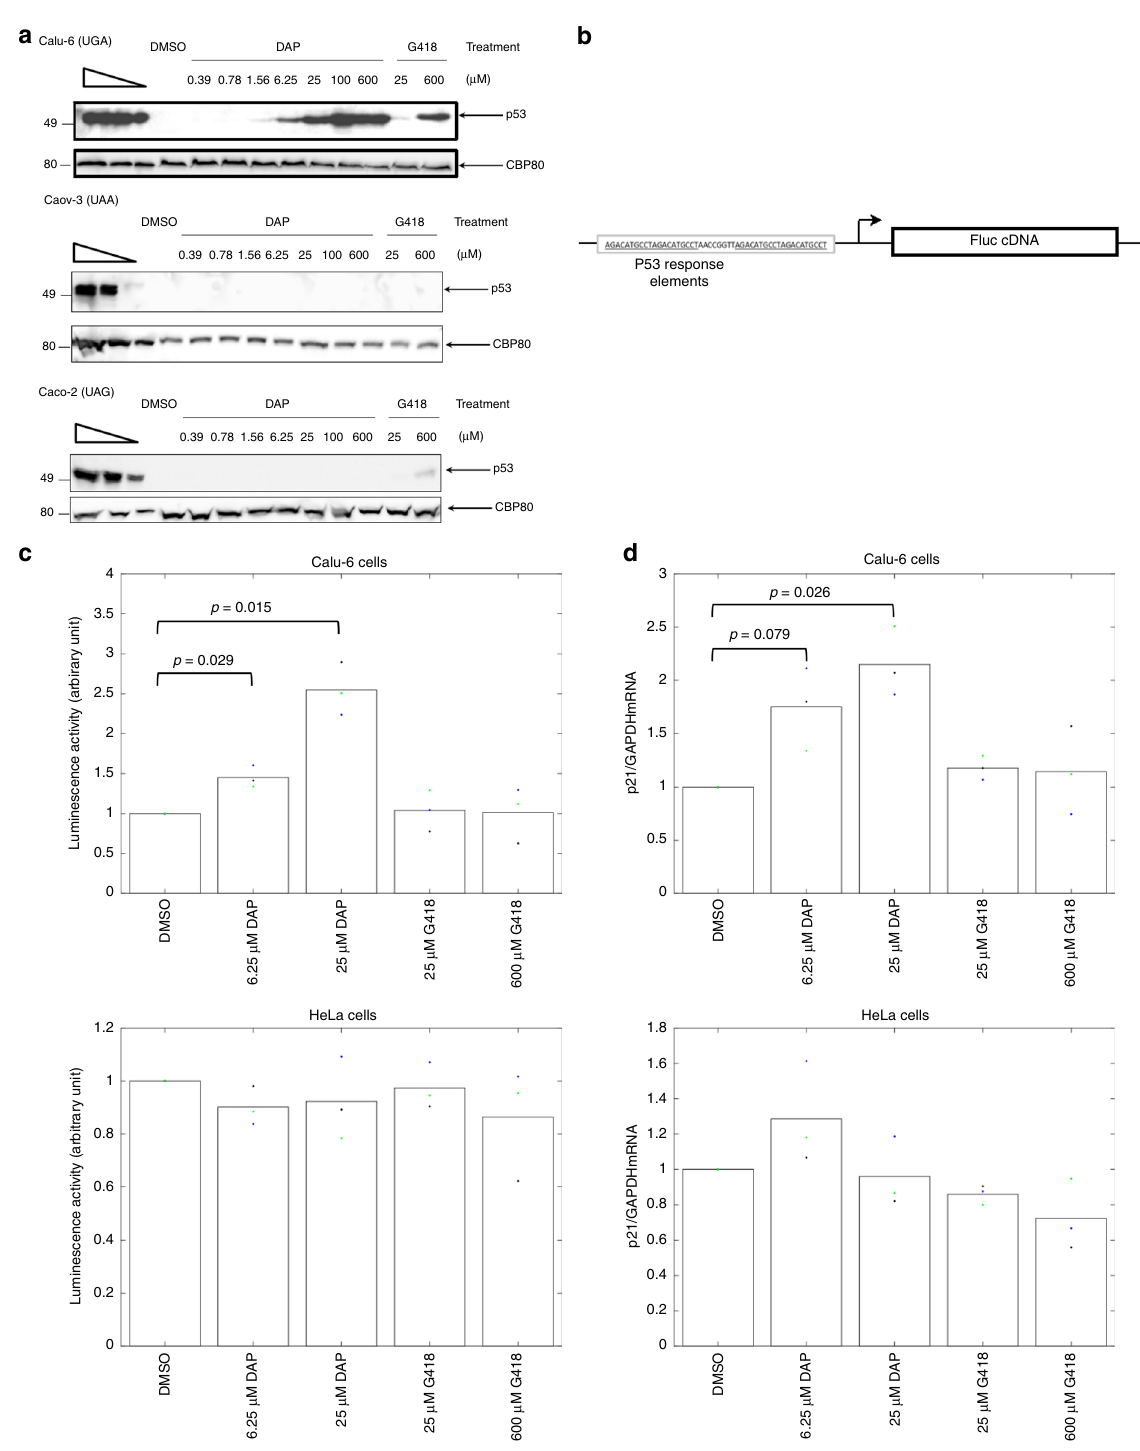
Fig. 2 DAP restores the synthesis and function of p53 in Calu-6 cells. a DAP restores expression of the endogenous TP53 gene if it carries a UGA nonsense mutation but not if it carries a UAA or UAG nonsense mutation. Calu-6 (top), Caov-3 (middle), and Caco-2 (bottom) cells were incubated with increasing amounts of DAP or G418 before protein puri fi cation and monitoring of the p53 protein level by western blotting. The three leftmost lanes show twofold serial dilutions of untreated HeLa cell extract. The molecular weight is indicated to the left of each gel. b Schematic representation of the construct used to measure the function of p53. The construct carries a cDNA encoding the fi re fl y luciferase under a promoter having two p53-responsive elements (underlined). The arrow indicates the transcription start. c Luciferase activity in Calu-6 (upper panel) and HeLa cells (lower panel) transfected with the construct described in b and treated with DMSO, DAP, or G418. The luciferase activity depends on the amount of functional p53 protein. d Level of p21 mRNA measured by quantitative RT-PCR in Calu-6 (upper panel) and HeLa cells (lower panel) treated with DMSO, DAP, or G418. The level of p21 mRNA is related to the amount of functional p53 protein synthesized in the cell. The results presented in panels b and c are representative of at least two independent experiments., p -values ( p ) were calculated using Student ’ s t -test. Source data are provided as a Source Data fi